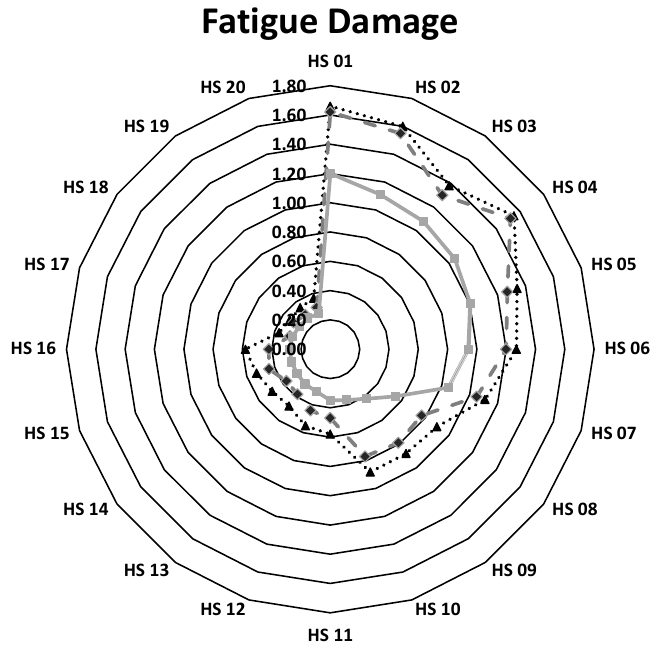
Figure 16. Fatigue damage at weak points.